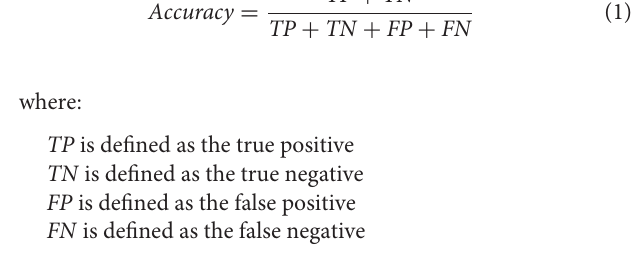
TABLE 5 | Results of statistical parameters for COVID-CT with 80% training data on 1,000 images. Statistical parameters